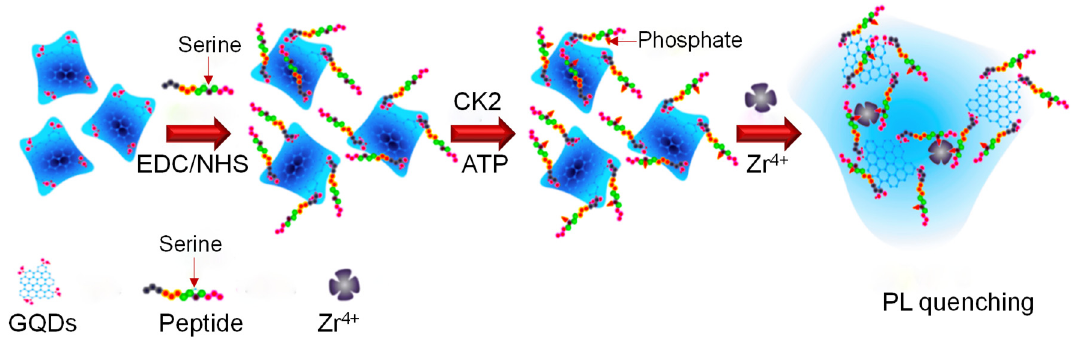
Figure 6. A GQD sensor based on PL for screening protein kinase activity [162].